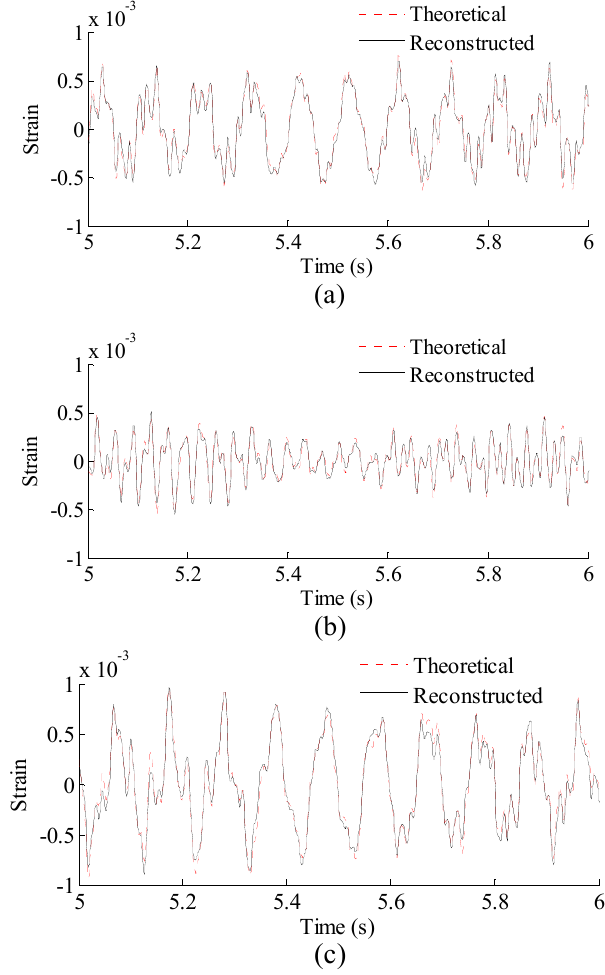
Figure 5. Reconstructed and theoretical strain responses for three locations (Loc. 1–3, Loc. in the paper are short form of location number) in Figure 2. Results are concentrated on 5–6 s for clear presentation. ( a ) Results for Loc. 1; ( b ) results for Loc. 2; and ( c ) results for Loc. 3.